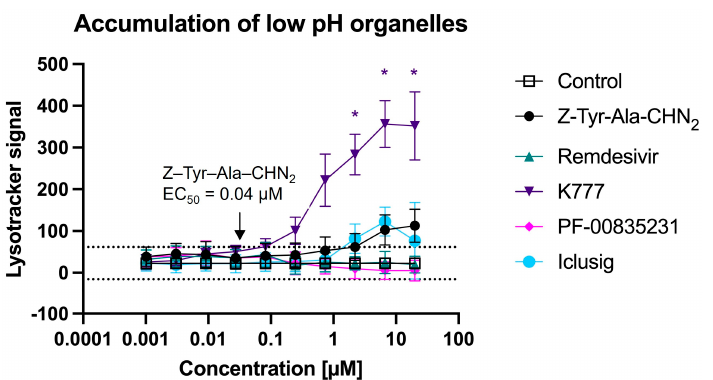
Figure 7. HCI assay with LysoTracker to compare organelle accumulation between different com- pounds in HeLa-hACE2 cells. The dotted horizontal lines represent the mean ±3 × SD of the LysoTracker signal from the virus control. * is indicative for significant organelle accumulation (ad- justed p < 0.05) at the corresponding concentration relative to the virus control, as determined by using two-way analysis of variance with Šidák correction for multiple comparisons. The intra-experiment dependency of the data is taken into account. The mean values ± SD are based on four